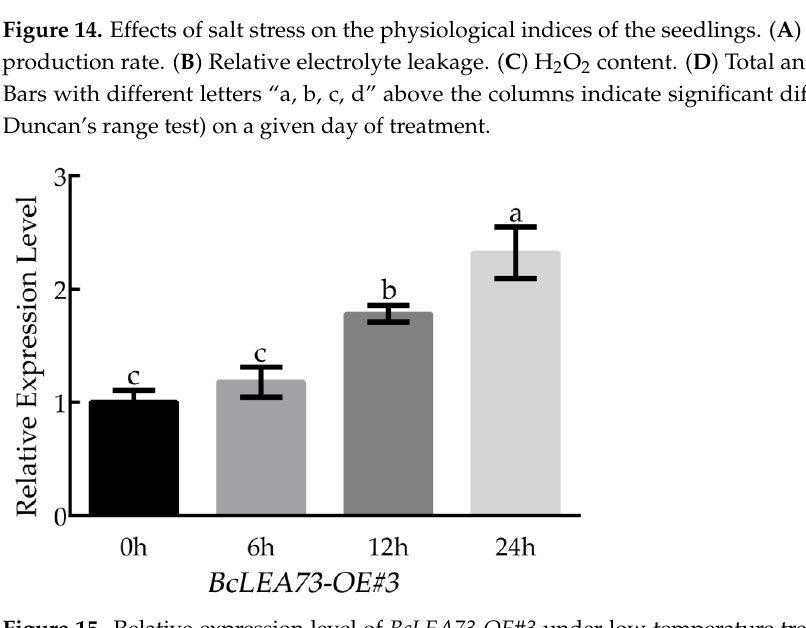
Figure 14. Effects of salt stress on the physiological indices of the seedlings. ( A ) Superoxide anion production rate. ( B ) Relative electrolyte leakage. ( C ) H 2 O 2 content. ( D ) Total antioxidant capacity. Bars with different letters “a, b, c, d” above the columns indicate significant differences ( p < 0.05, Duncan’s range test) on a given day of treatment.